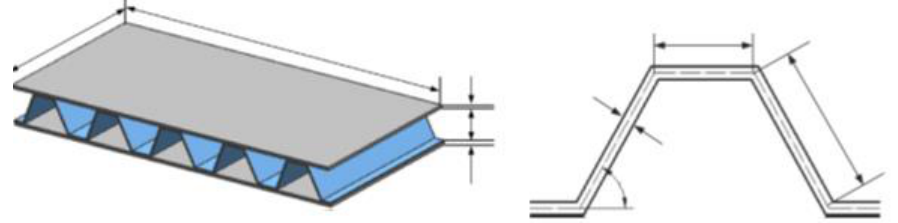
Figure 19. Cross-sections of NavTruss sandwich structure. Reproduced with permission from ref. [215]. Copyright 2013. Elsevier Ltd.